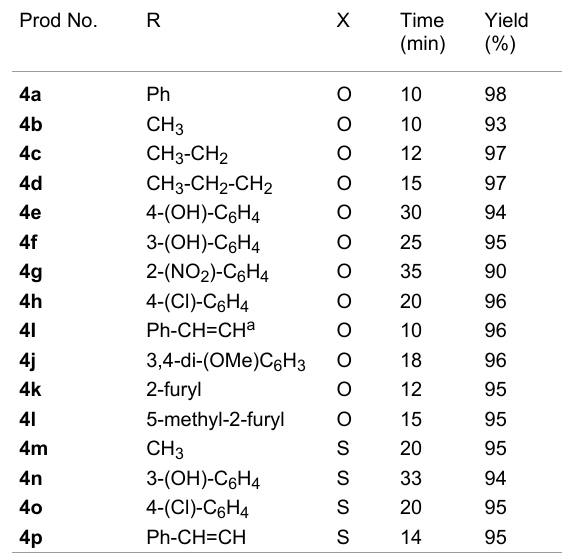
Table 1: Titanium silicate (TS-1) catalyzed synthesis of DHPMs. Prod